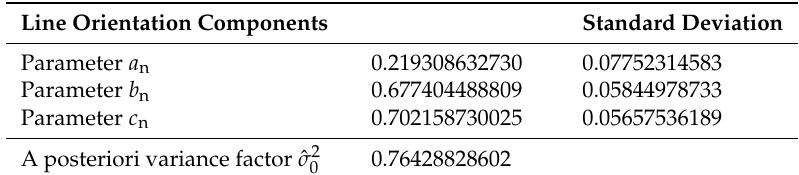
Table 2. Direct TLS solution from Section